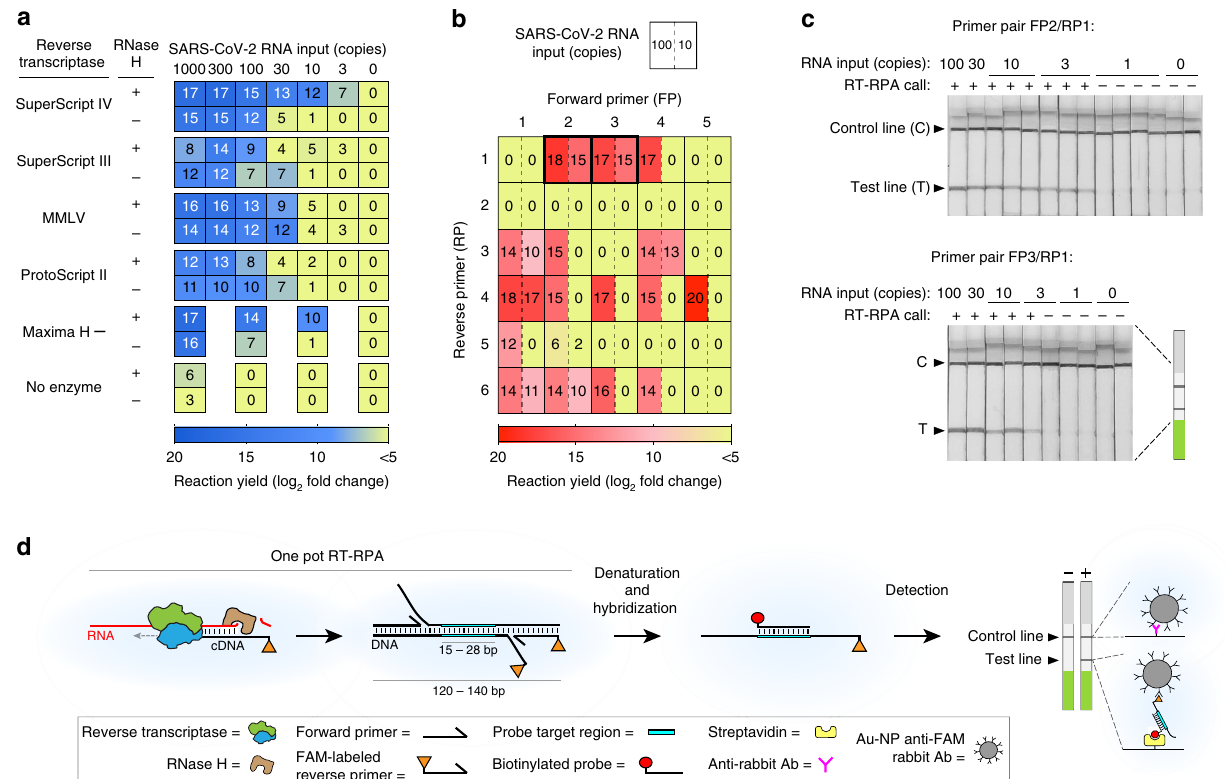
Fig. 1 Development of eRPA: an enhanced RT-RPA based assay for detection of SARS-CoV-2. a Screen for reverse transcriptase (RT) enzyme and effect of RNase H. SARS-CoV-2 RNA was ampli fi ed by RT-recombinase polymerase ampli fi cation (RT-RPA) using fi ve different RTs with or without RNase H addition and the yield of each reaction was determined by quantitative PCR (qPCR). At least two biological and two technical replicates were used for each data point; numbers in each square represent mean log 2 fold ampli fi cation. Samples labeled as zero yielded only non-speci fi c ampli fi cation products. b Primer optimization screen. SARS-CoV-2 RNA was ampli fi ed by RT-RPA using forward and reverse primers speci fi c to the S gene. The yield of each reaction was determined by qPCR using the same primer pair as for the RT-RPA reaction. Data represent mean log 2 fold ampli fi cation from two technical replicates for each RNA input. c Lateral fl ow strip readout of RT-RPA reactions of SARS-CoV-2 RNA using primer pairs FP2/FAM-labeled RP1 and FP3/ FAM-labeled RP1. All lateral fl ow strips contain a control (C) and test (T) band. d Schematic of eRPA. Viral RNA is fi rst copied to cDNA by RT, then degraded by RNase H. The cDNA product is ampli fi ed by RPA using a forward and a FAM-labeled reverse pair of primers speci fi c to the target sequence. The ampli fi ed material is then denatured and hybridized to a biotinylated probe. Dual FAM-labeled and biotin-labeled products are detected on lateral fl ow strips. Source data are available in the Source Data fi